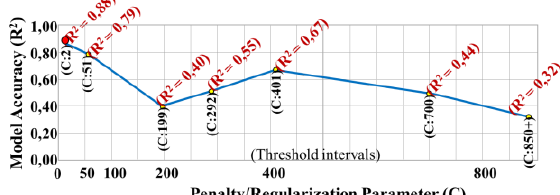
Figure 2 . Model accuracies for different penalty/regularization (C) parameters